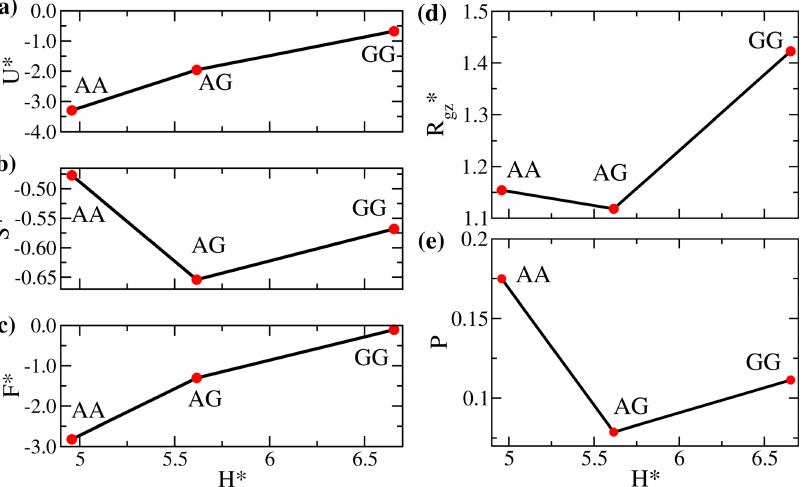
Figure 4. ( a ) Scaled internal energy per bead ( U ∗ ), ( b ) scaled entropy per bead ( S ∗ ), ( c ) scaled free energy per bead ( F ∗ ), ( d ) ratio of the z -component actual gyration radius to the reference gyration radius ( R ∗ gz ), and ( e ) degree of the interpenetration of polymers ( P ) versus the dimensionless gap thickness ( H ∗ ) of AA, AG, and GG systems.